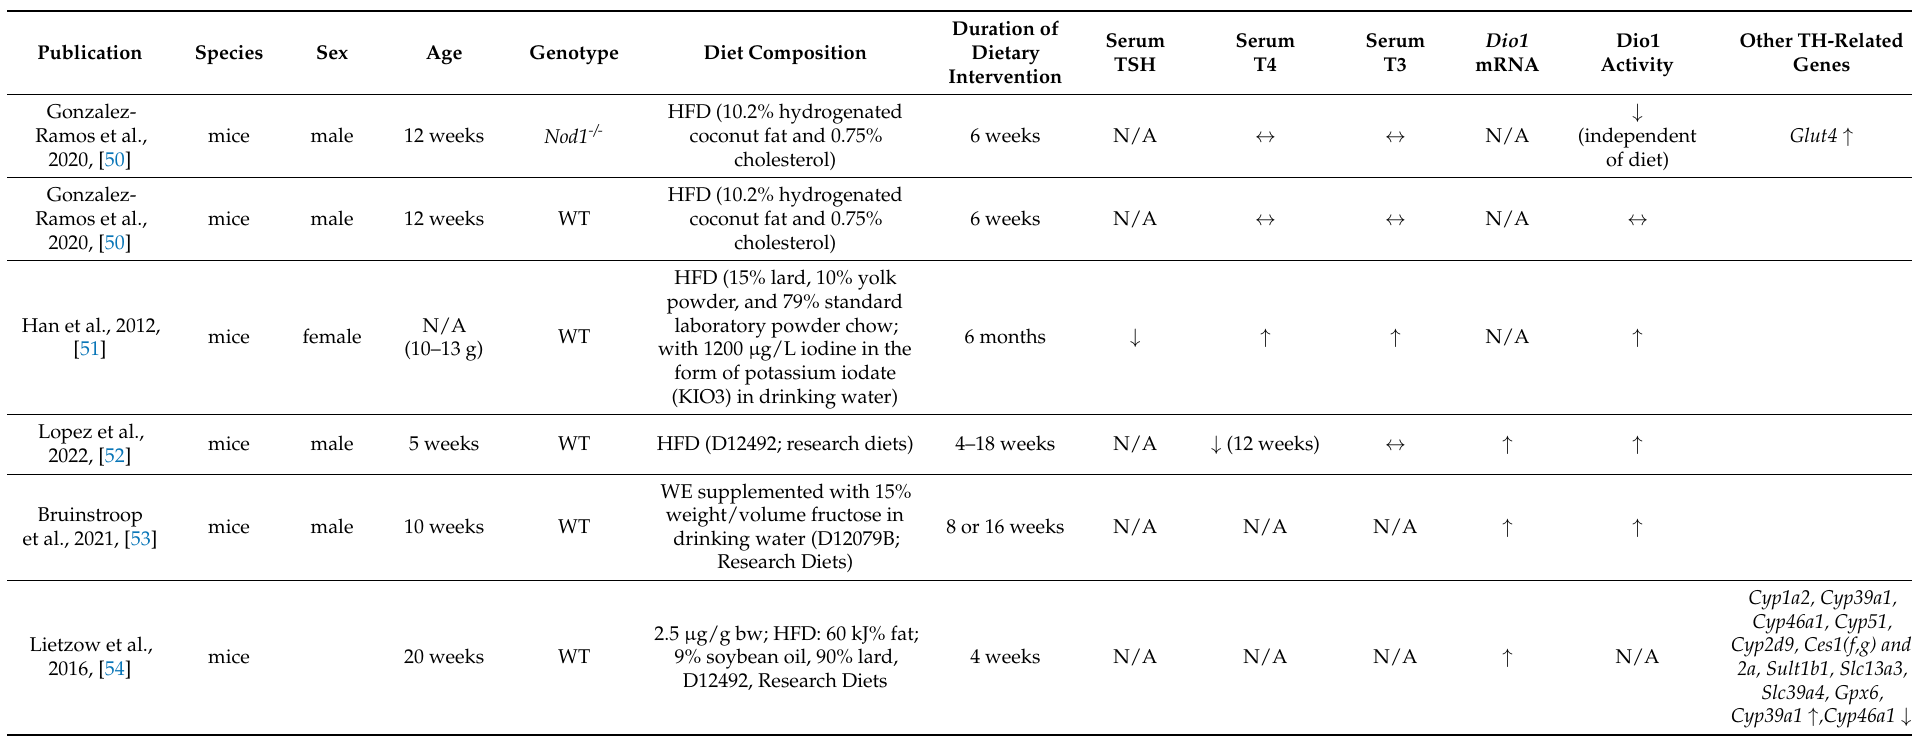
Table 3. Regulation of the TH system through dietary interventions. N/A: not available, ↔ : no change, ↓ : lower than control, ↑ : higher than